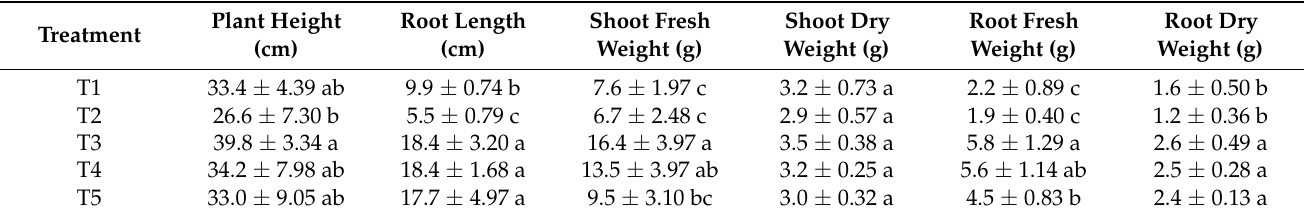
Table 2. Effect of different treatments on growth parameters of tomato plants under greenhouse conditions. Plant Height Root Length Shoot Fresh Treatment (cm) (cm) Weight (g)